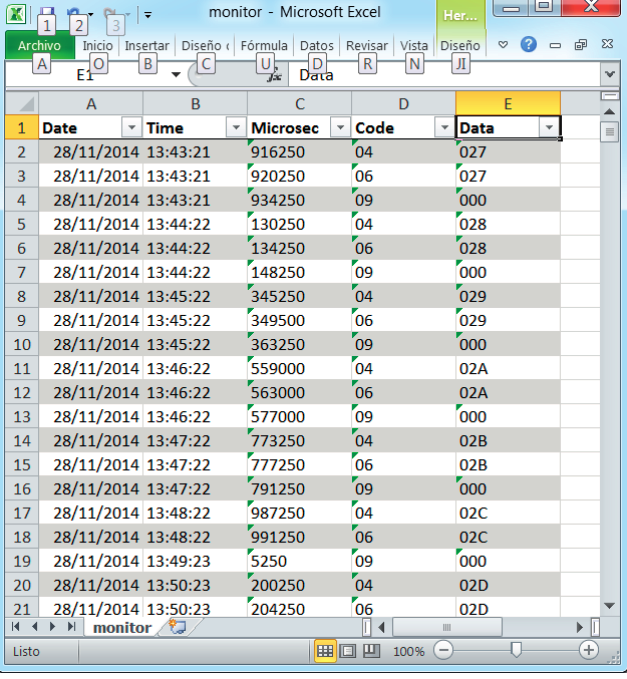
Figure 6. Information recovered from the SD card attached to the monitor